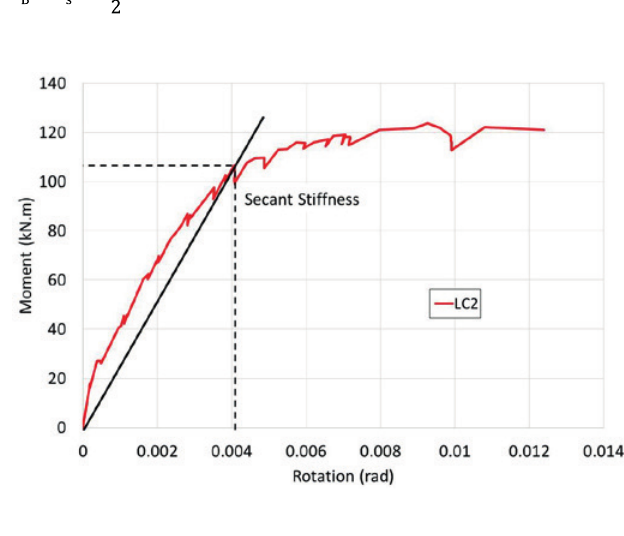
Moment-rotation curve: specimens LC1 and LC2